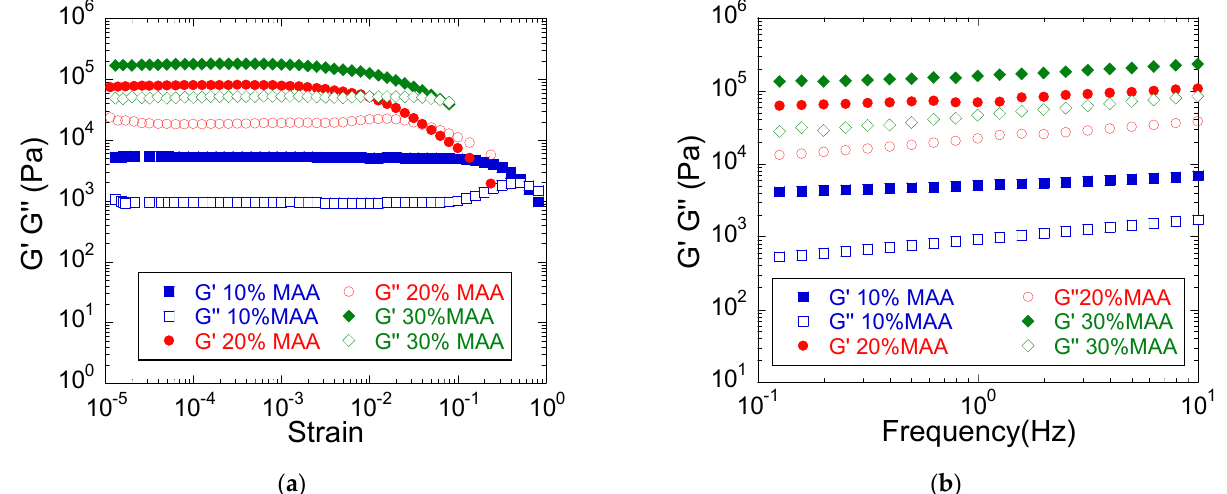
Figure 1. The influence of the monomer concentration on the viscoelastic properties of PMAA hydrogels ( a ) Amplitude sweep measurements ( b ) Frequency sweep measurements. Hydrogel composition: MAA, 2 mol% BIS based on MAA, 0% MMT.